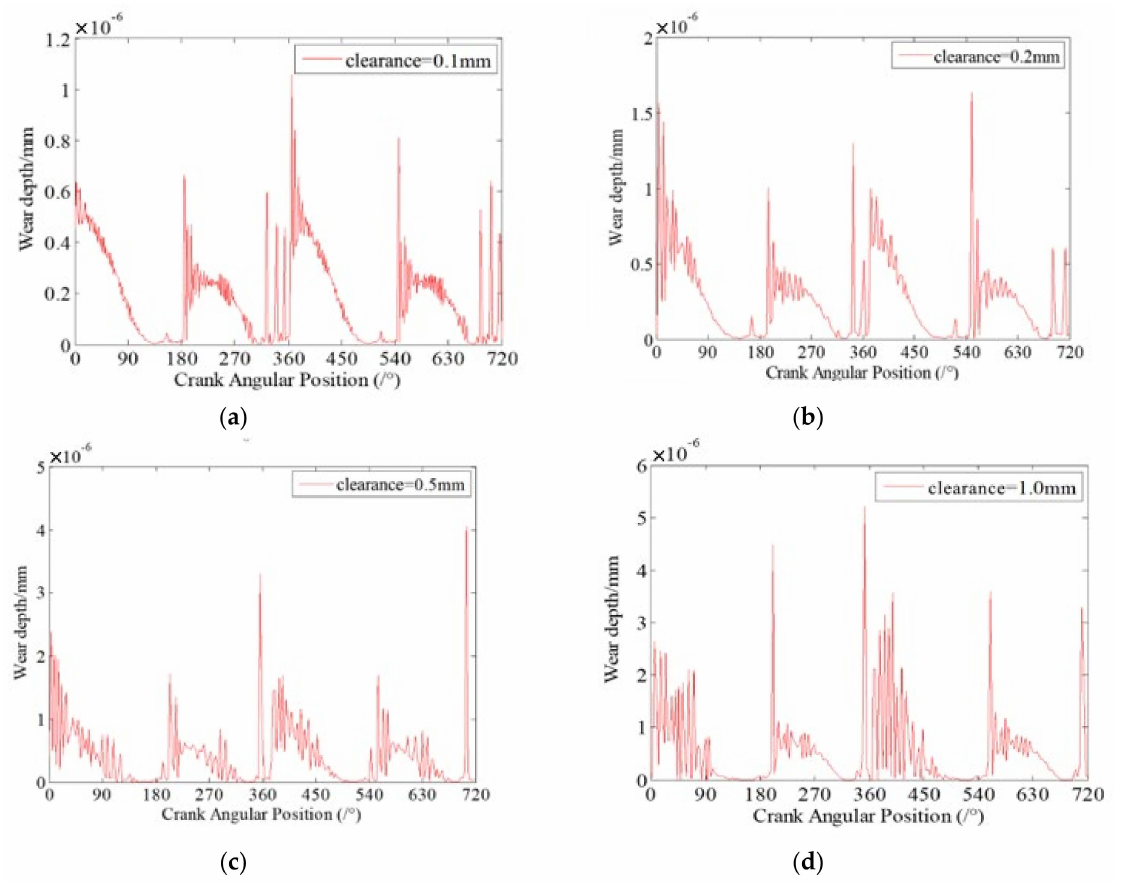
Figure 7. Dynamic wear depth in revolute clearance joint A for different clearance sizes. ( a ) 0.1 mm; ( b ) 0.2 mm; ( c ) 0.5 mm; ( d ) 1